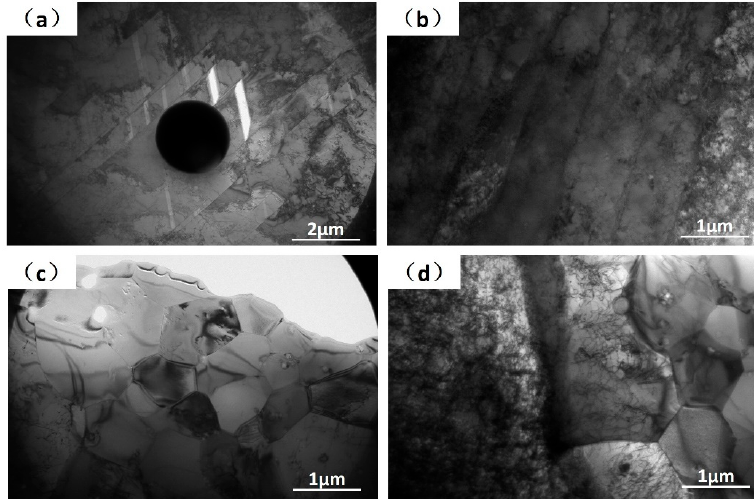
Figure 6. Transmission electron microscope (TEM) images are shown from band ( a , b ) and cellular microstructures ( c , d ). The black circular inclusion in (a) is a Cr–Si–O particle.